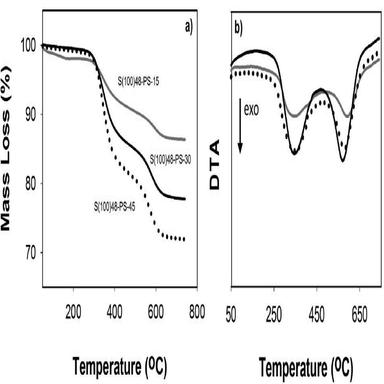
TGA (a) and DTA (b) analyses of S(100)48-PS composite series.